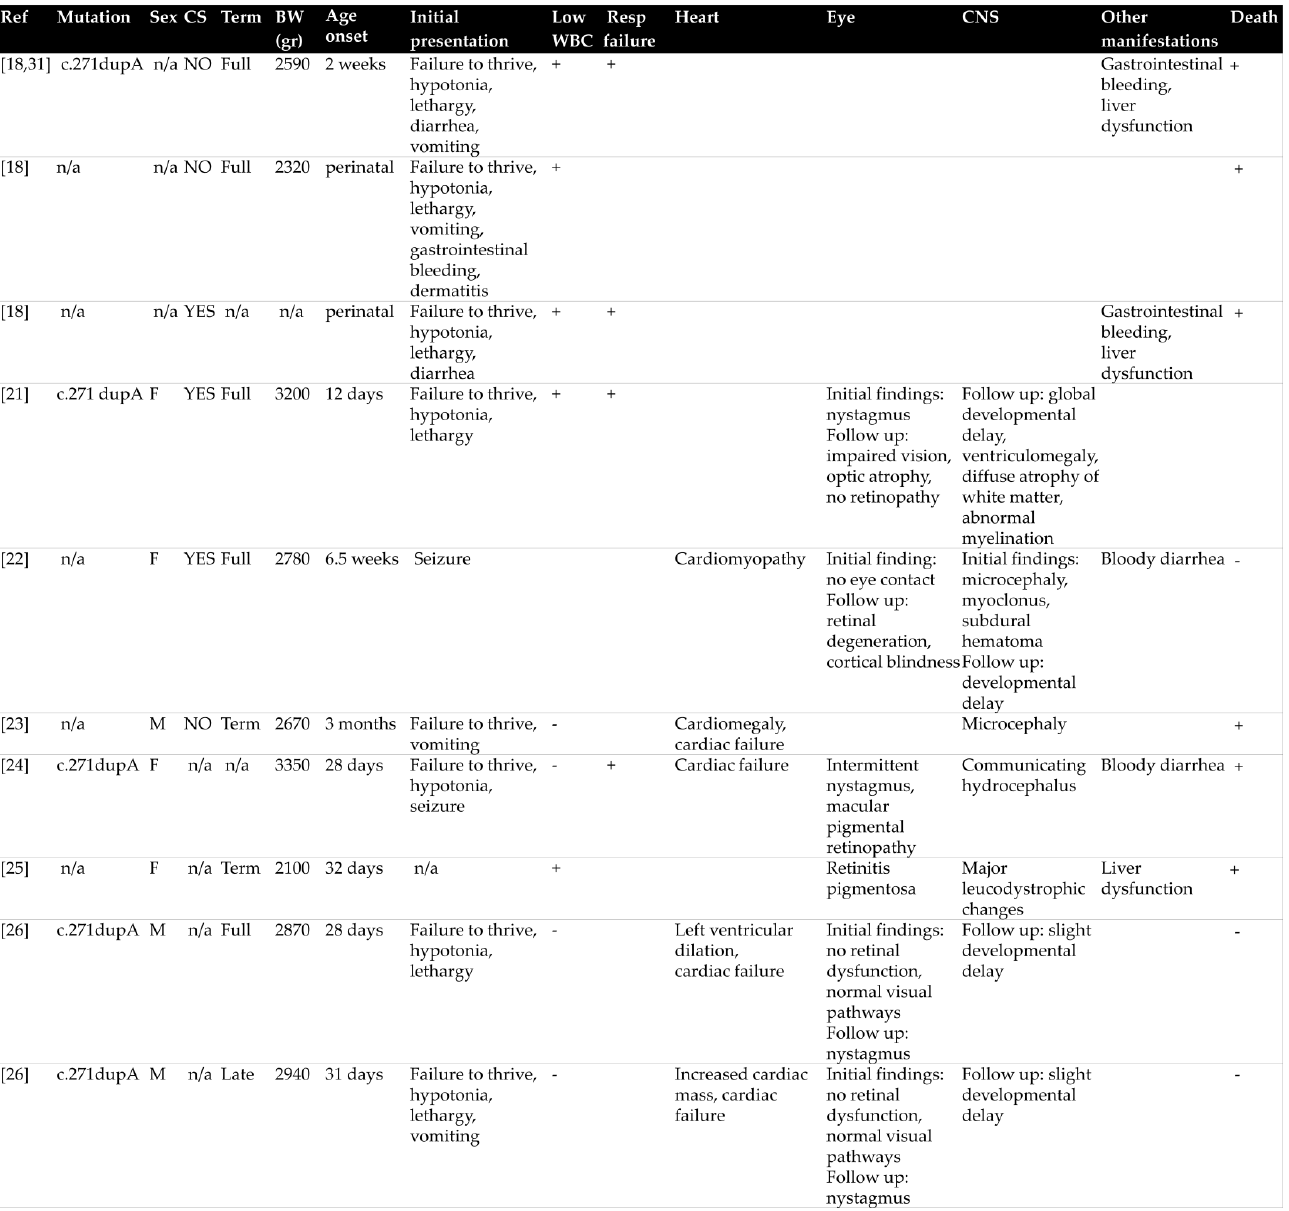
Figure 2. Dermographic parameters, perinatal history, initial presentation, extra-renal manifestations, type of MMACHC mutation and outcome of patients with early-onset cyanocobalamin C defect and hemolytic uremic syndrome. BW: birth weight, CNS: central nervous system, CS: consanguinity, WBC: white blood cells, MRI: magnetic resonance imaging, Resp failure: respiratory